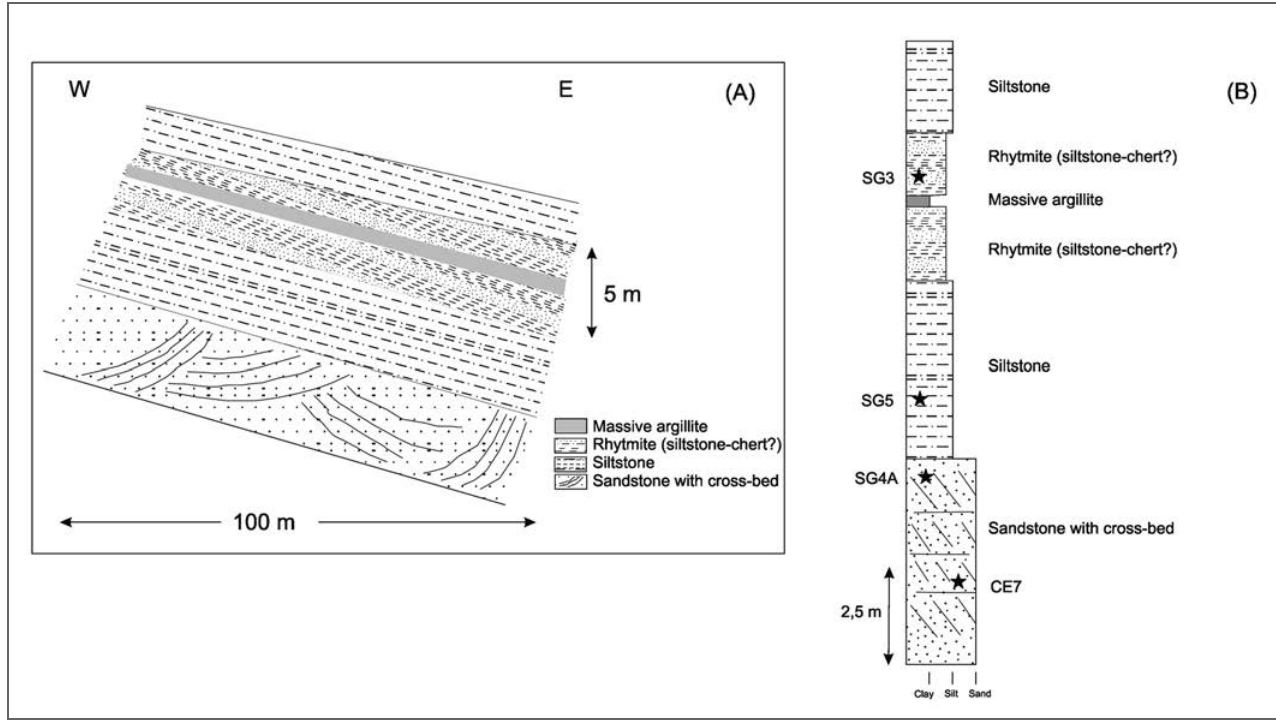
Figure 3. (A) Schematic W-E cross-section of the Novo Progresso Formation, and (B) interpreted sedimentary section, with the approximate location of samples used for isotopic analyses (black stars; sample numbers as in Table